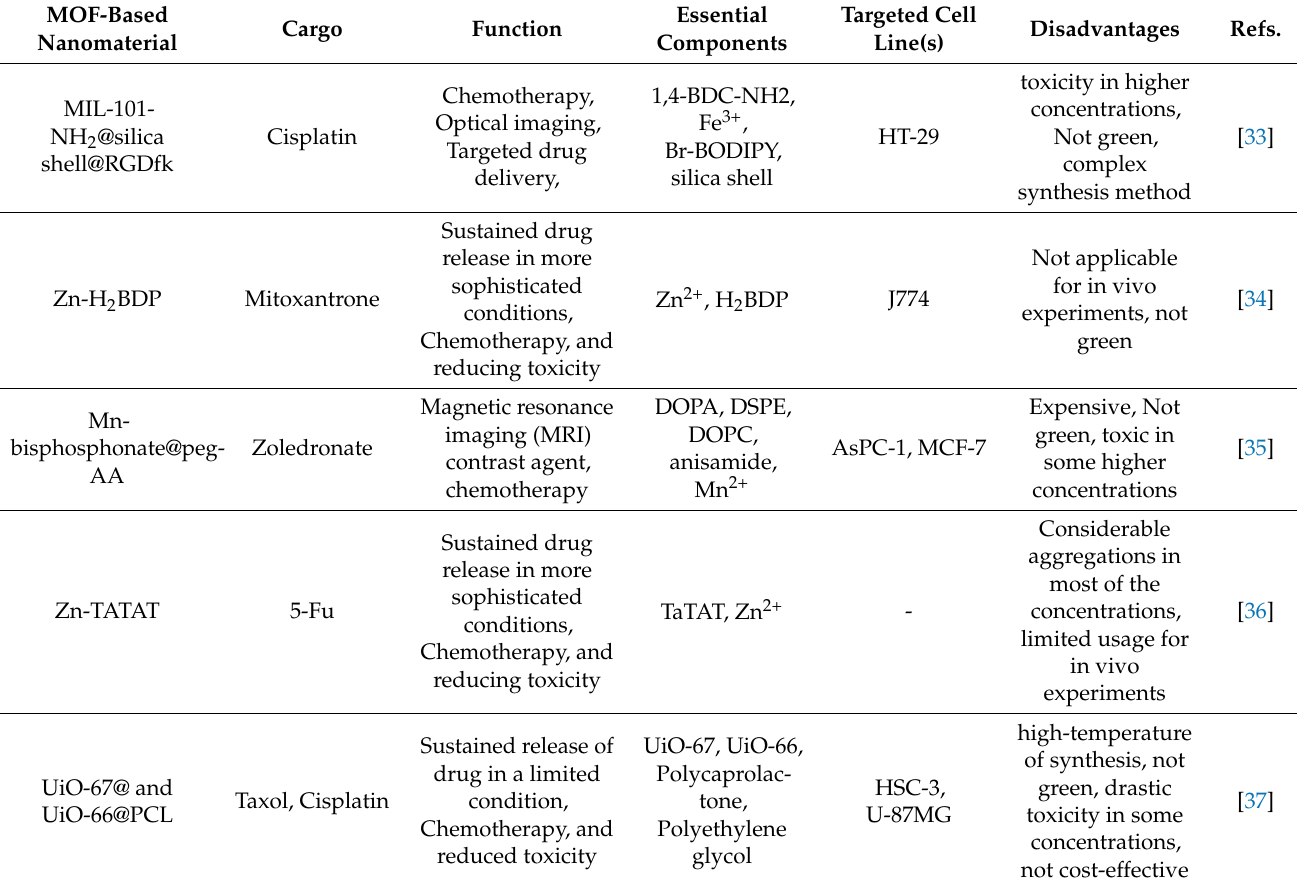
Table 1. A literature survey of the MOF-based nanomaterials for cargo